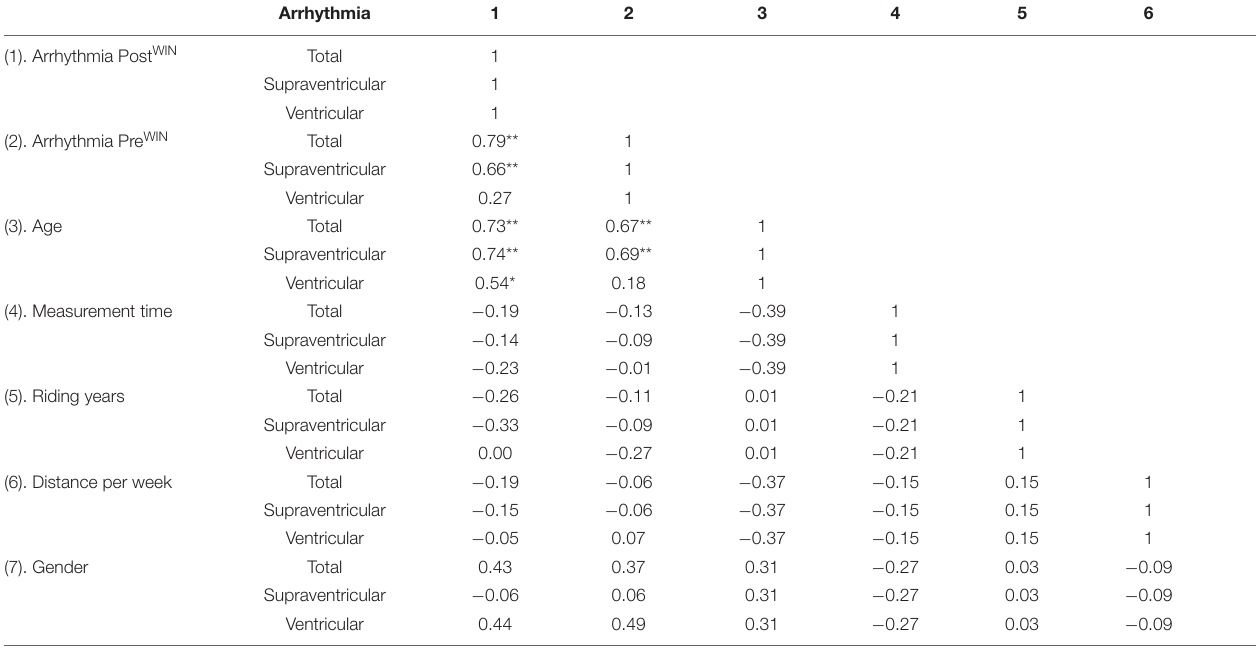
TABLE 3 | Correlations comparing arrhythmia, age, days post-ride measurement performed, riding years and weekly training distance. Arrhythmia